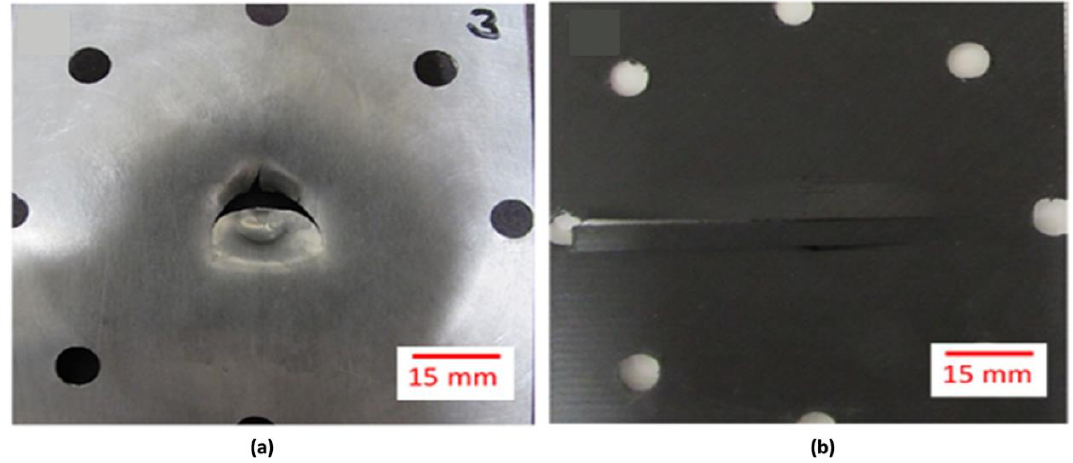
Figure 10. Perforation response of ( a ) Aluminum and ( b ) Composite specimens.